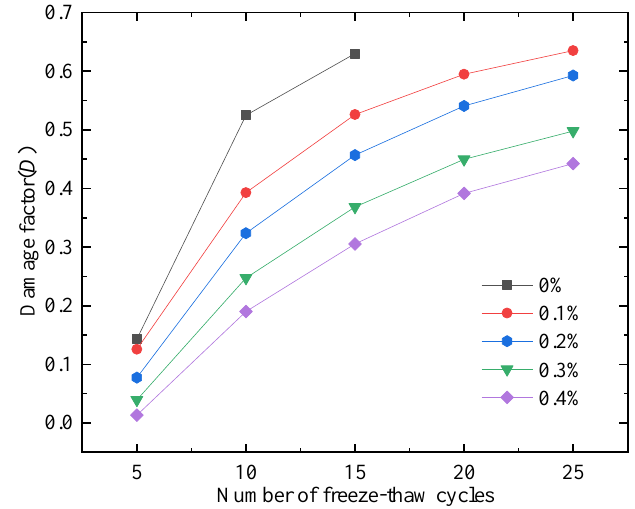
Figure 28. Damage factor of freeze – thaw cycle test.